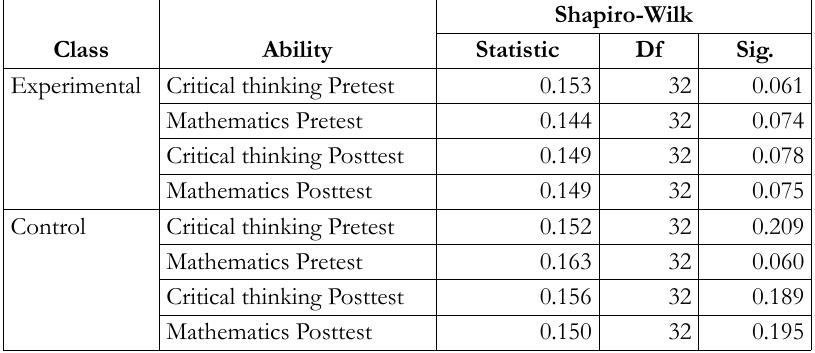
Table 7. Result of normality